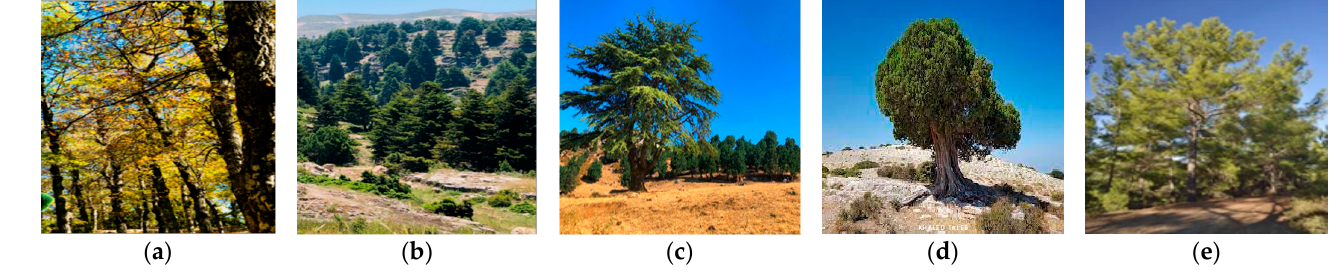
Figure 2. Forest types: ( a ) Quercus Cerris, ( b ) Abies cilicica, ( c ) Cedrus Libani, ( d ) Juniperus excelsa, ( e ) Pinus brutia . Table 1. Information about the collected field samples.